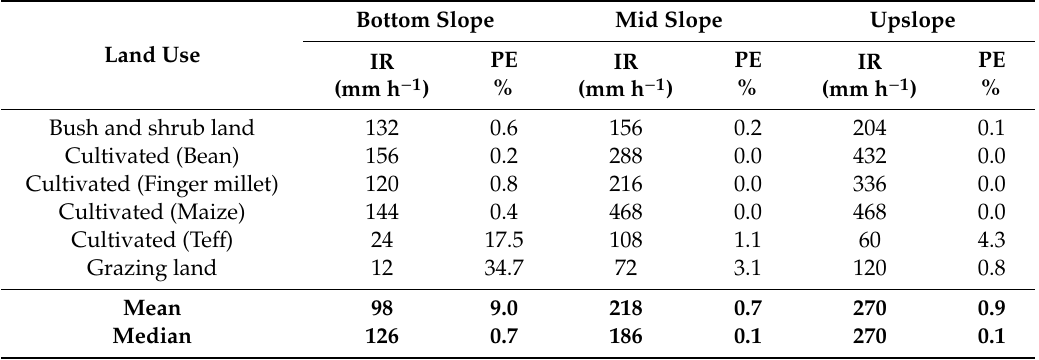
Table 2. Infiltration rates (IR) and the probability of exceedance (PE) of di ff erent land uses at three slope categories in the Gomit